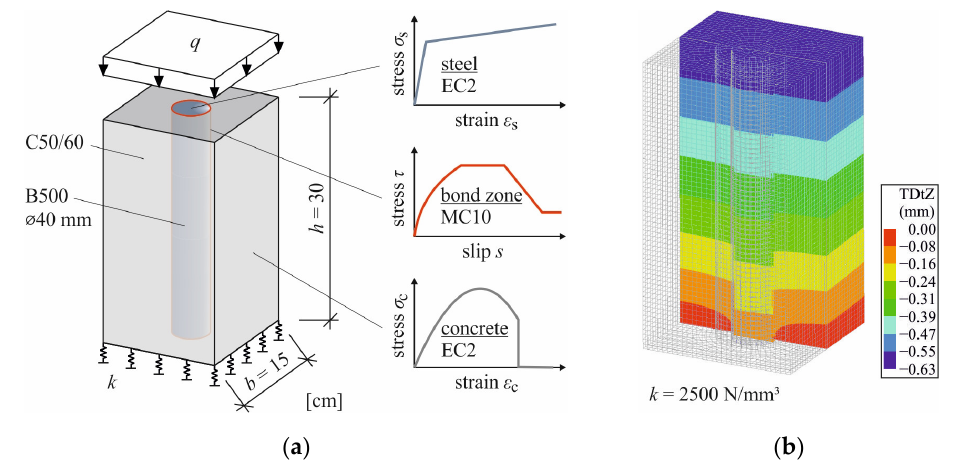
Figure 14. ( a ) FE model of reinforced concrete member with elastic spring support; ( b ) vertical deformation plot.